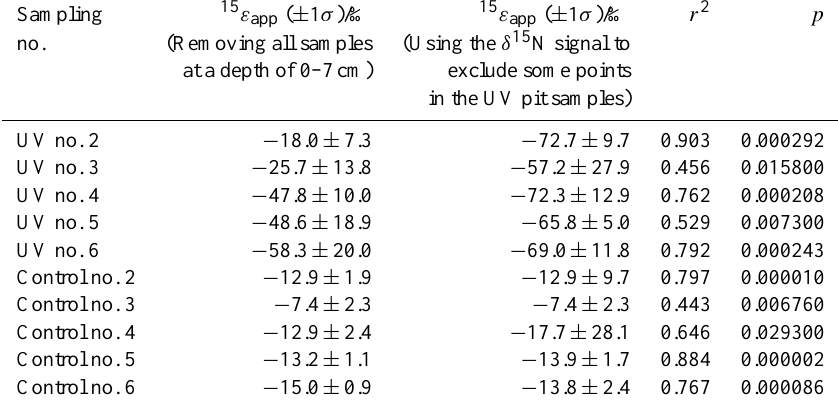
Table 2. The apparent nitrogen isotopic fractionations determined for both pits excluding all the samples between 0 and 7cm or using the δ 15 N signal to identify whether samples were influenced by external processes. The correlation coefficients ( r 2 ) and significance ( p) are also given for the derived 15 ε app values derived using the δ 15 N signal. Note that due to insignificant change in nitrate mass and isotopic composition, the linear fits for samples no. 0 and no. 1 from both pits were only weakly correlated and are not given in Table 2. Sampling 15 ε app ( ± 1 σ )/‰ 15 ε app ( ± 1 σ )/‰